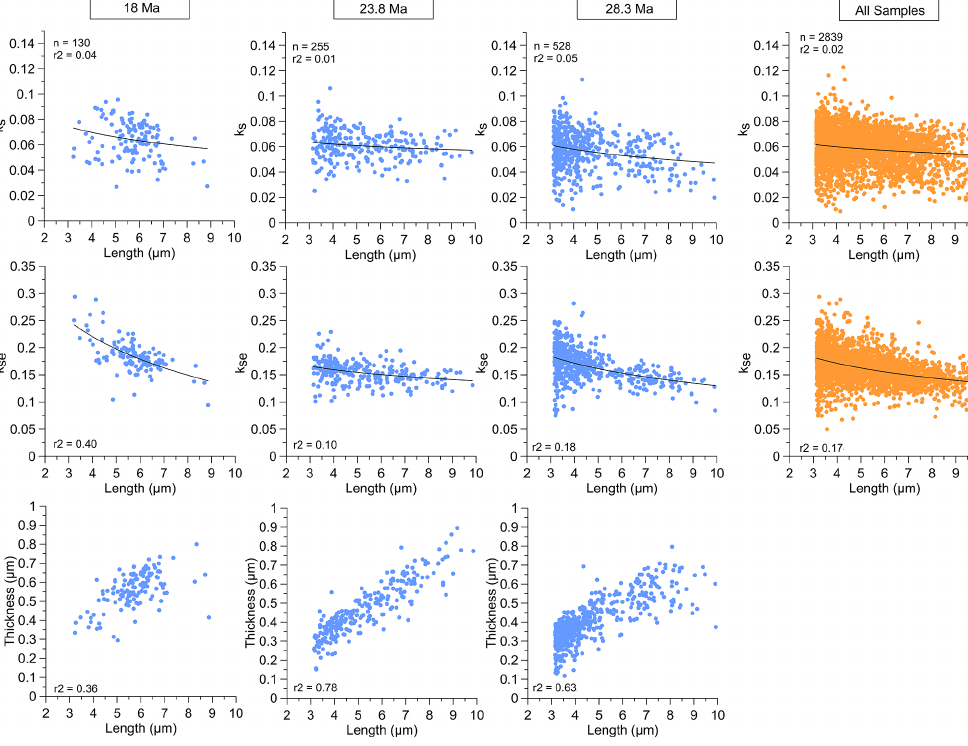
k se (Table S2, r = 0 . 78) and strongly correlated ( r = 0 . 81) with k se of the full population of